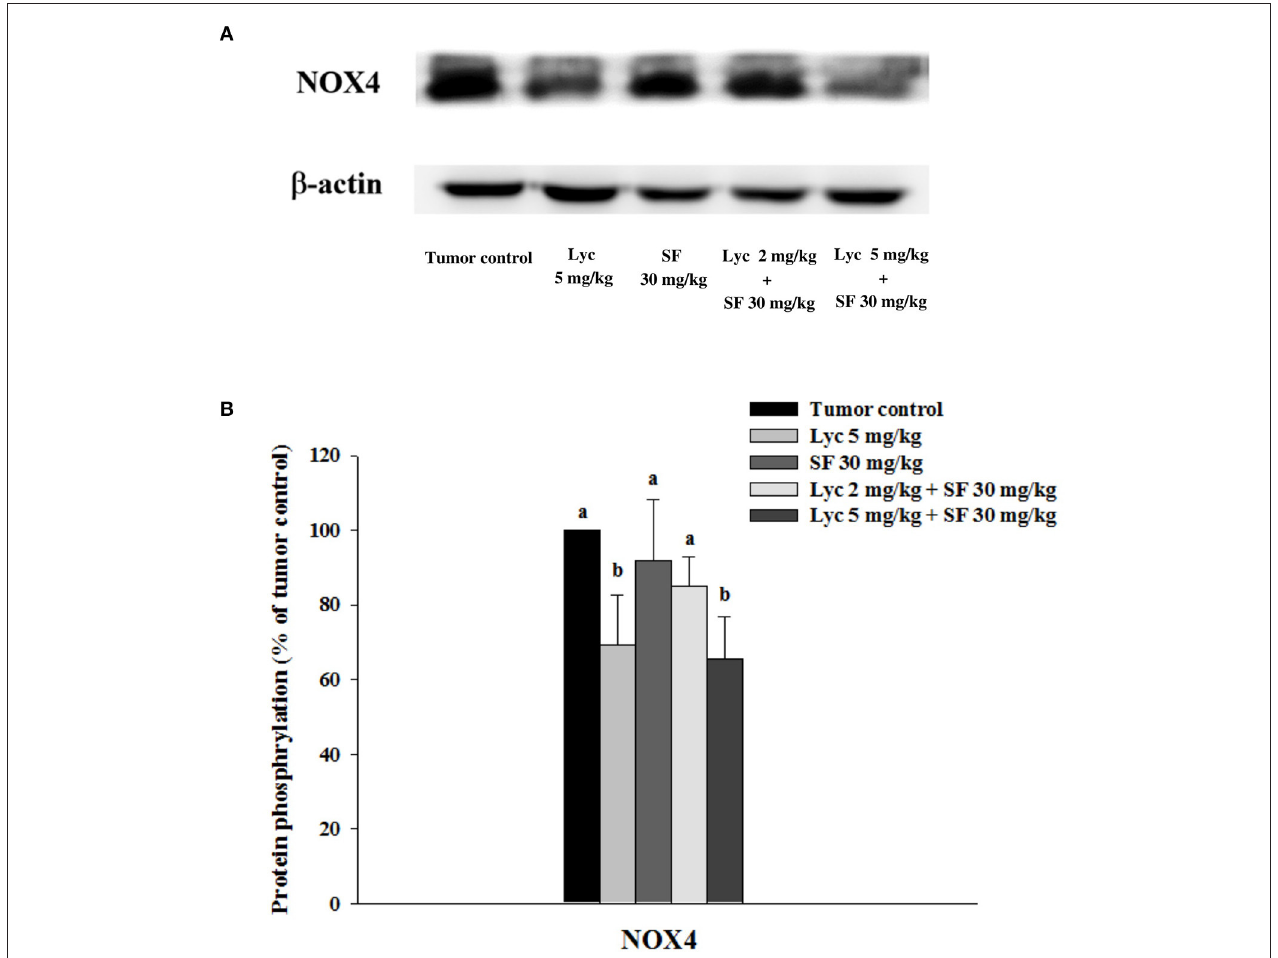
FIGURE 8 | Effects of lycopene (Lyc) alone, sorafenib (SF) alone, or their combination on NOX4 protein expression in lung tissues of the C57BL/6 mice xenografted LLC cells. Nine days after the tumor cell injection, mice were orally supplemented with SF (30 mg/kg) daily, Lyc (5 mg/kg) twice per week or the combined treatment (mice were supplemented with SF (30 mg/kg) daily, and Lyc (2 and 5 mg/kg) twice per week) for 28 days. (A) Western blot analysis of NOX4 and -actin. (B) Quantitative results of the protein expression of NOX4. Data are means ± SD, n = 7 – 8; values not sharing an alphabetic letter are significantly different ( P < 0.05).